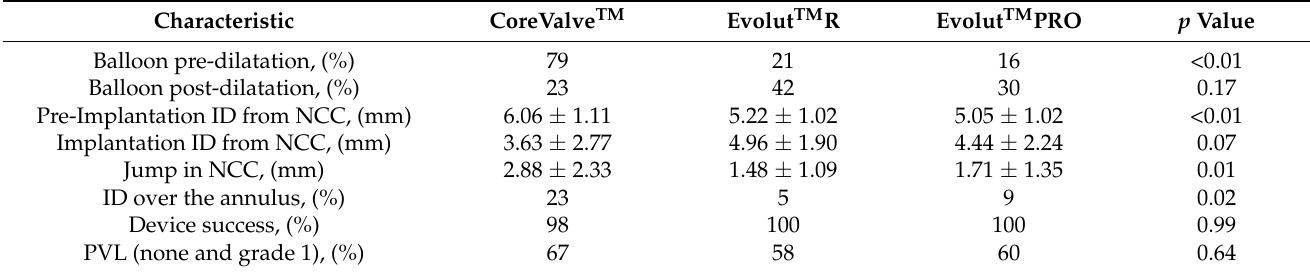
Table 2. Peri-procedural